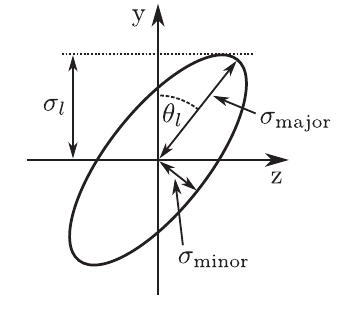
FIG. 11. Maximum extent of an ellipse described by the major and minor axes σ and σ , respectively, here representing major minor σ y;z of the bivariate Gaussian laser photon